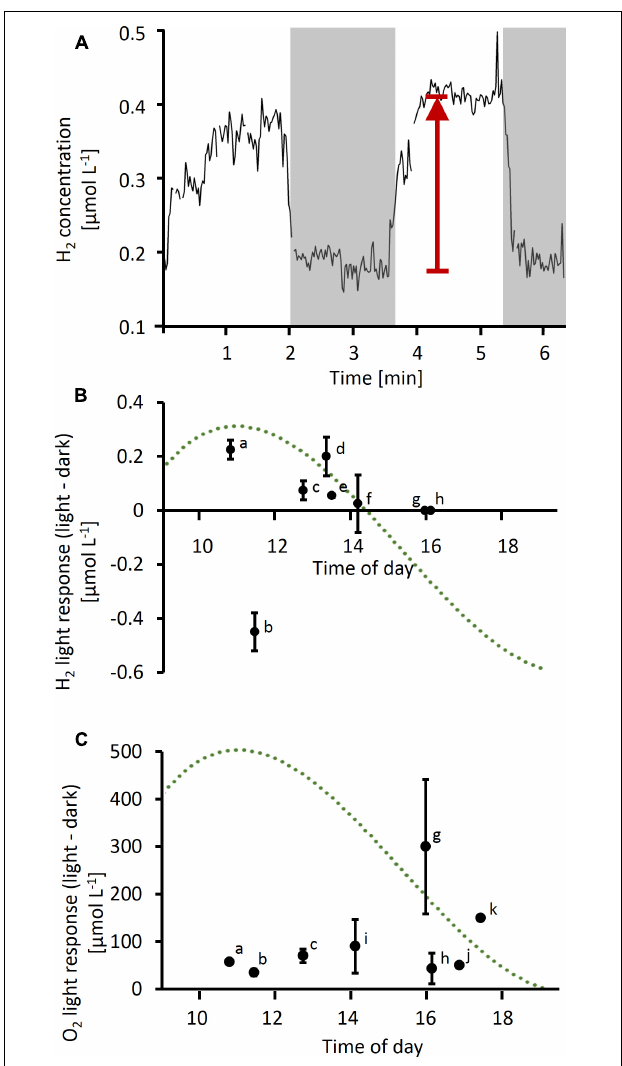
FIGURE 3 | (A) Example of time series measurement of H 2 performed on a single Trichodesmium colony. Gray shading indicates dark phases, arrow indicates light response (as plotted in B ). (B,C) Light response in H 2 (B) and O 2 (C) concentrations (i.e., difference in concentration in light versus dark) measured at different times of the day. Data points labeled with the same letter in (B) and (C) were measured simultaneously using two microelectrodes (H 2 and O 2 ) on the same colony. Error bars indicate standard deviation of multiple measurements on the same colony ( n ≥ 2, except for colonies j and k). The dotted line represents a typical diel cycle in N 2 fixation (arbitrary units), which was obtained by a third order polynomial fit to N 2 fixation